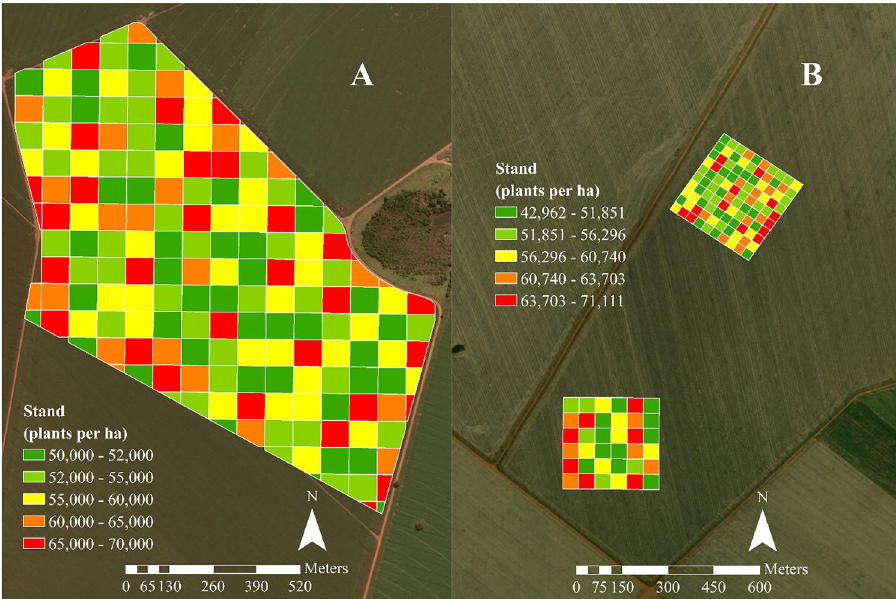
Figure 4. Final plant stands in sites A and B used for path analysis and tree decision and in area C used to validate results. The software used to create this Figure was ArcGIS Desktop (v10.5, https:// deskt op. arcgis. com/ en/ system- requi remen ts/ 10.5/).